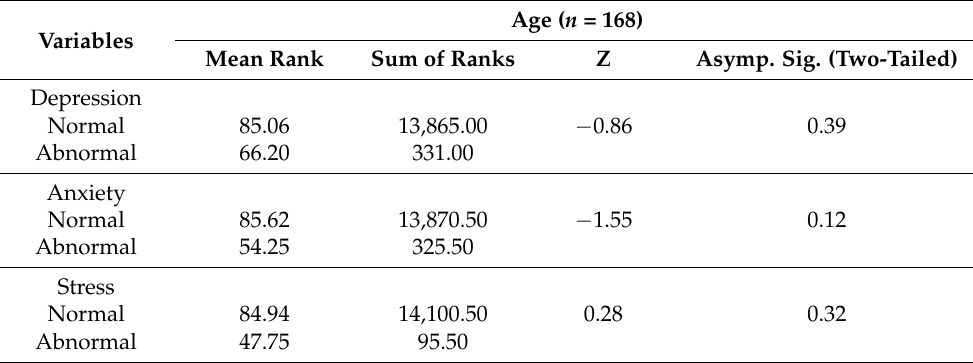
Table 5. Association between psychological distress and age.